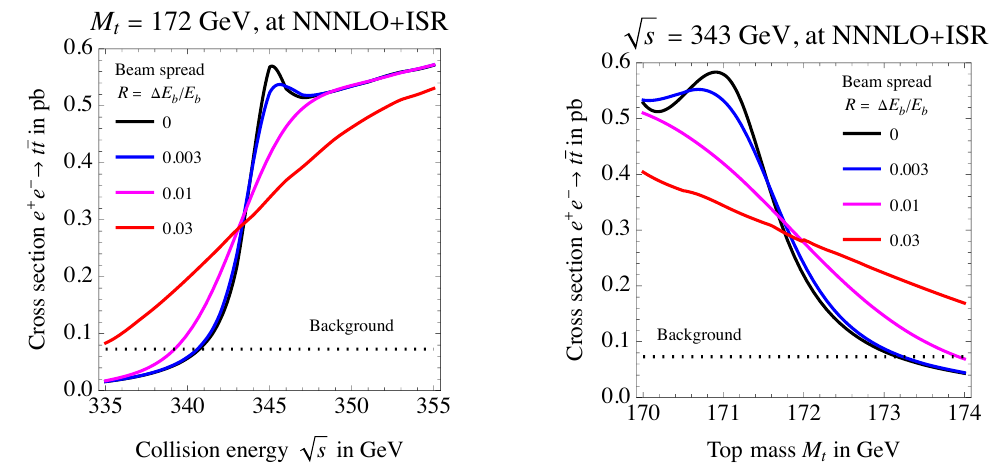
Figure 5 . As in figure 3, but with Initial State Radiation included, as appropriate for a e + e −